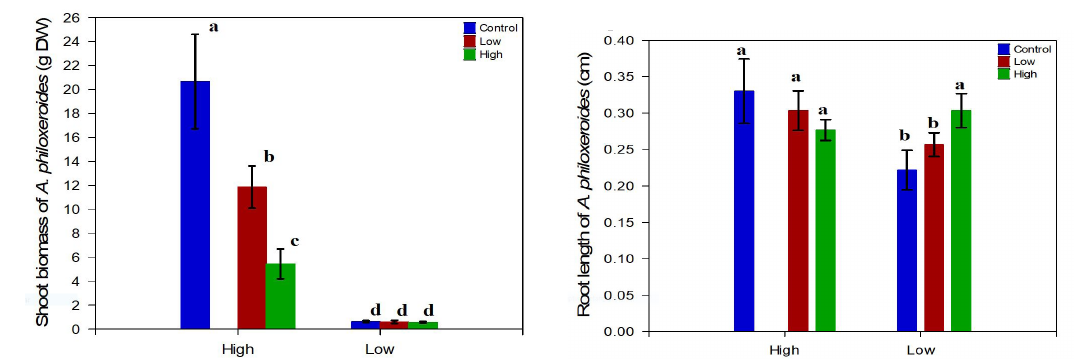
Figure 3. Shoot biomass of Alternanthera philoxeroides according to the density of neighbor specie (H density or L density), the level of nutrients (H nutrient or Lnutrient) and the treatment control.